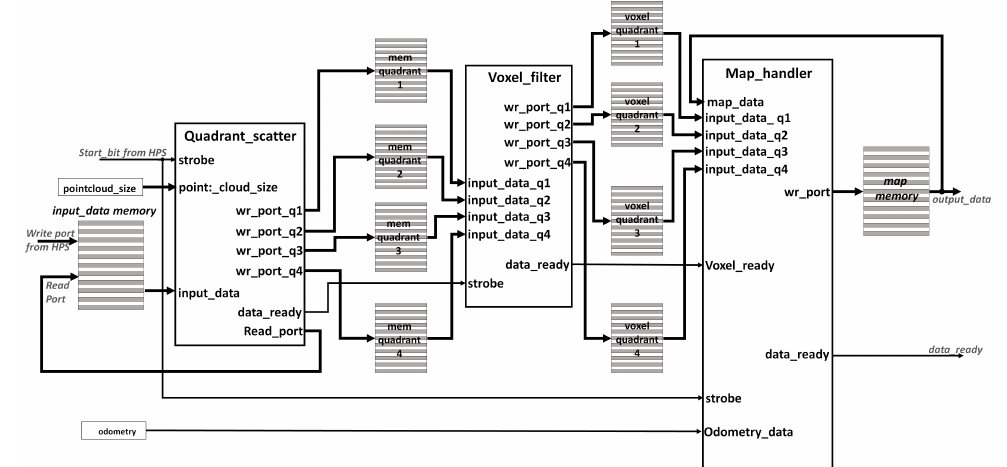
Figure 4. Hardware Architecture of the eSoC-LAM